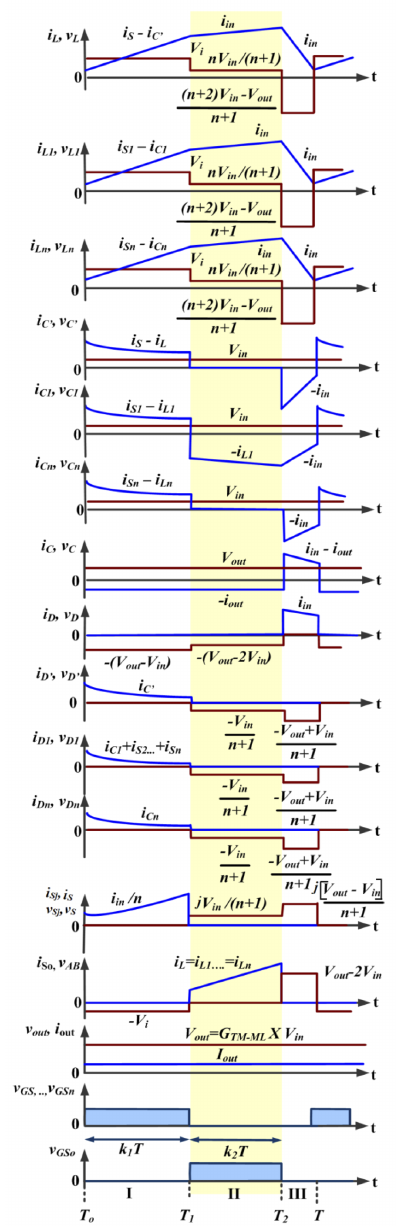
Figure 3. Voltage and current typical waveforms in CCM.